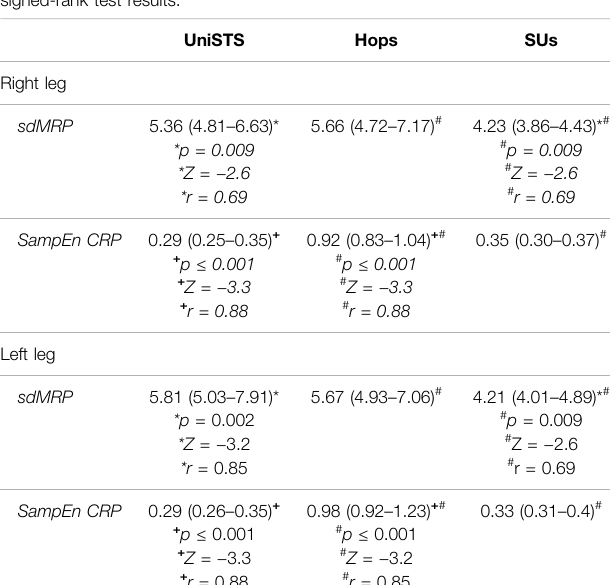
TABLE 1 | The right and left shank-thigh linear and nonlinear coordination variability analysis results in the UniSTS, Hops, and SUs and the Wilcoxon signed-rank test results.